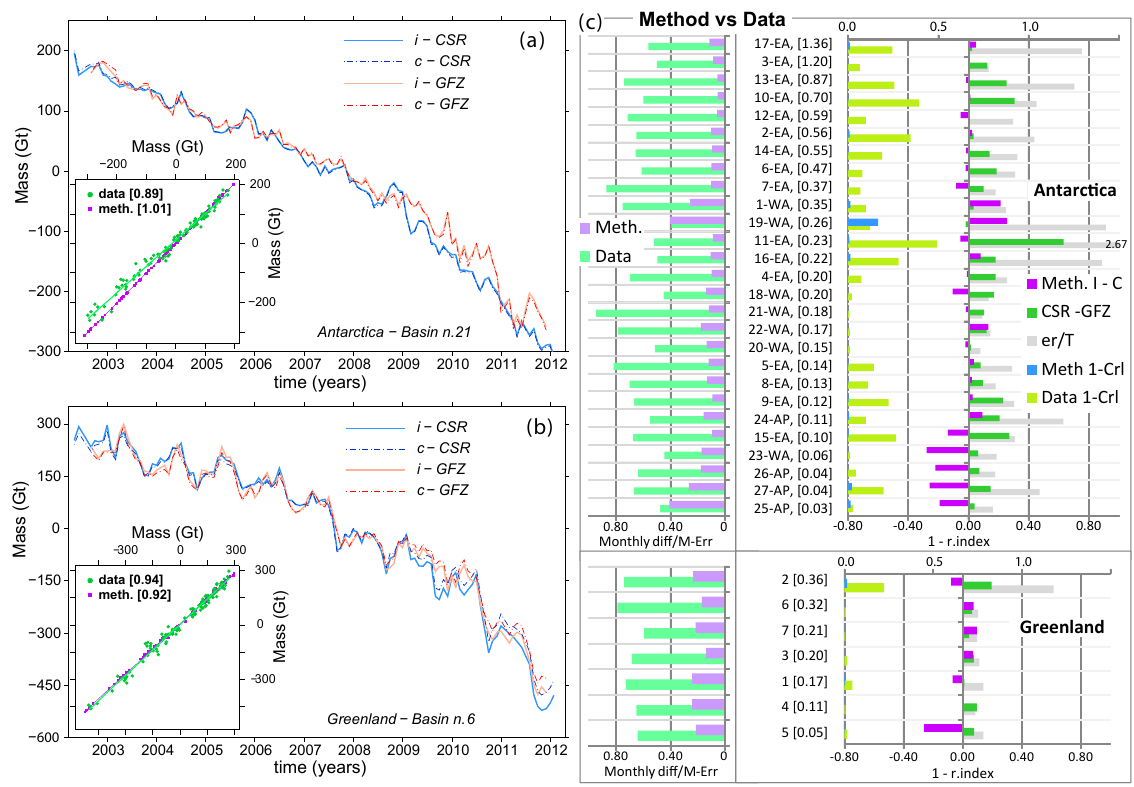
Fig. 4. RL04 monthly solution for basin 21 for Antarctica (a) in Amundsen sector and basin 6 for Greenland (b) . Comparison between the two methods and two data sets (CSR and GFZ): in the legend the inversion method (Method 1) is indicated by “i” and solid lines, and the conversion method (Method 2) is indicated by “c” and by dash-dotted lines. The use of CSR is indicated by light-blue and blue lines, and the GFZ by light-red and red lines. Each of the small dispersion graphics shows the time series obtained with inversion versus conversion methods (purple square), and the use of CSR versus GFZ data set (green dots). For each of these couple of time series the value of their regression index m (as in Eq. 3) is indicated in square parentheses. In panel (c) , the vertical axis indicates the basin (number, the region (EA, WA, AP) and area in 10 6 km 2 ) in descending order from the largest. For each basin, differences are plotted for the two methods (purple) and for the two data sets (green). The light colors represent (the quadratic sum of) the monthly difference with respect to (the average of) the /T 2 as in Eq. (4), and the grey bar is the error on the same monthly errors. The normal colors represent 1 minus regression index m , i.e. δ T 21 trend as Figs. 8d and 9d with respect to the trend. The light-blue and yellow bars represent 1 minus the correlation coefficient for the use of different method and data set, respectively. When the correlation is below 75% (i.e. the related bars are larger than 0.25) the associated regression index is not